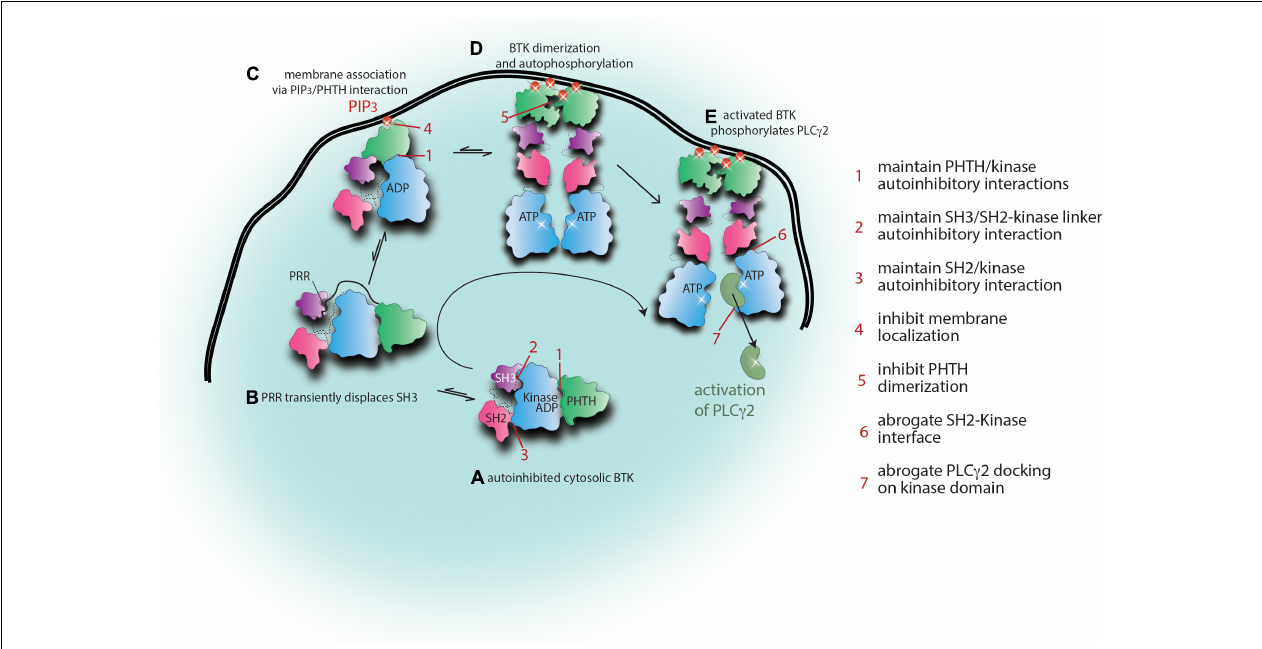
FIGURE 5 | Alternate approaches to targeting BTK. Snapshots of the activation scheme for BTK provide several areas to target for allosteric therapeutic development. Current knowledge of the BTK activation scheme is summarized here with cartoon representations. The domain colors are as in Figures 3 , 4 . (A) Briefly, autoinhibited cytosolic BTK adopts a compact domain arrangement with the PHTH docked onto the kinase domain blocking the active site (Pose 2) and the SH3 and SH2 domains adopting a SRC-like conformation. (B) Displacement of the SH3 domain from the distal side of the kinase domain by the proline-rich region (PRR) promotes transient opening of the autoinhibited structure which would promote regulatory domain accessibility to exogenous ligands (including PHTH domain sampling of the PIP 3 content in the plasma membrane). (C) Initial binding of the PHTH domain to PIP 3 might lead to domain rearrangement consistent with the Pose 1 PHTH/kinase interaction. (D) Once PIP 3 levels in the membrane surpass the required threshold, BTK engages PIP 3 via the canonical and peripheral binding sites in PHTH and BTK dimerization at the membrane is stabilized. Rearrangement of the regulatory domains ensues, the SH2 domain transitions to its activating position on the N-lobe, the hydrophobic stack is disassembled triggering exchange of ADP for ATP in the kinase domain allowing autophosphorylation. (E) Activated BTK phosphorylates its substrate PLC γ 2. Seven areas for potential allosteric therapeutic development are listed. These areas encompass stabilizing autoinhibited BTK (points 1, 2, and 3) and/or disfavoring activating or substrate contacts (points 4, 5, 6, and